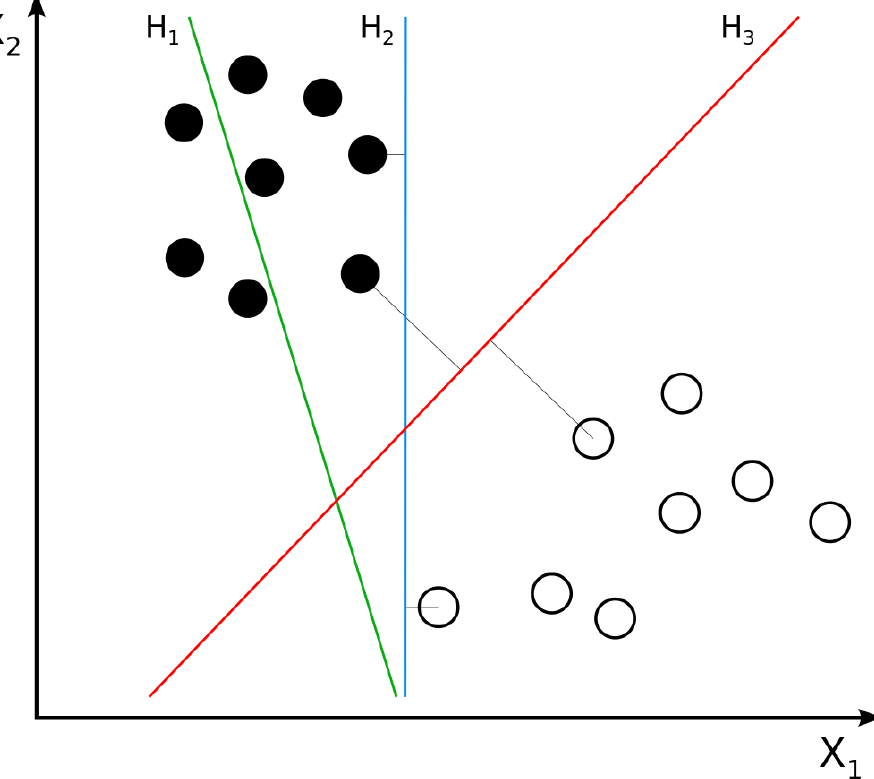
Figure 5. Example of two classes of linear SVM. H1 does not separate the classes. H2 separates the classes, but only with a small margin. H3 separates the classes with the maximal